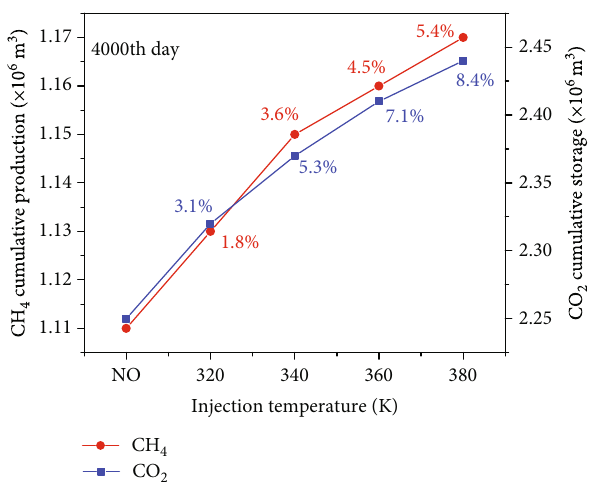
Figure 26: The cumulative CH